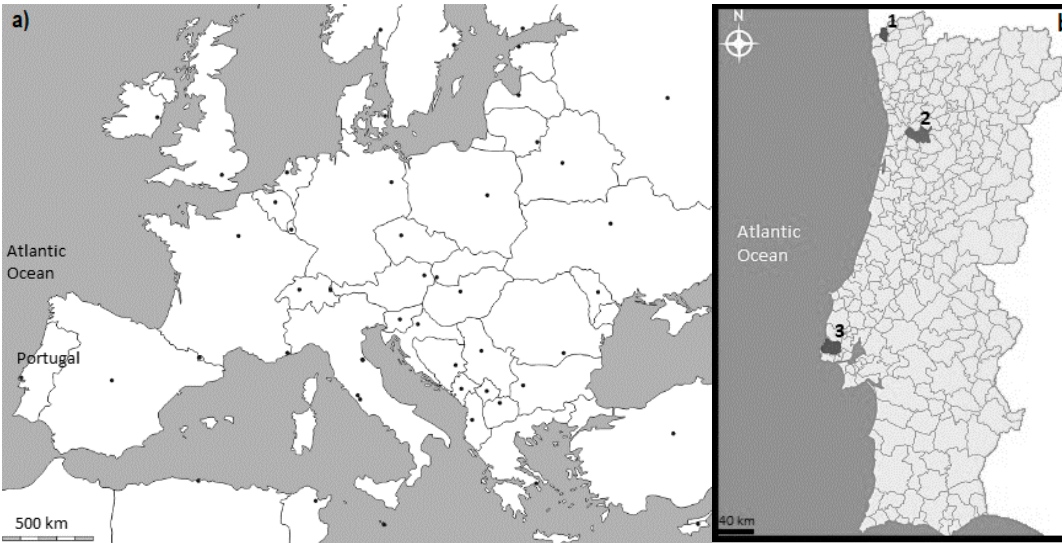
Figure 1. Study area: ( a ) Location of Portugal in Europe; ( b ) the three municipalities analyzed: 1. V. N. Cerveira; 2. Arouca; and 3. Sintra.